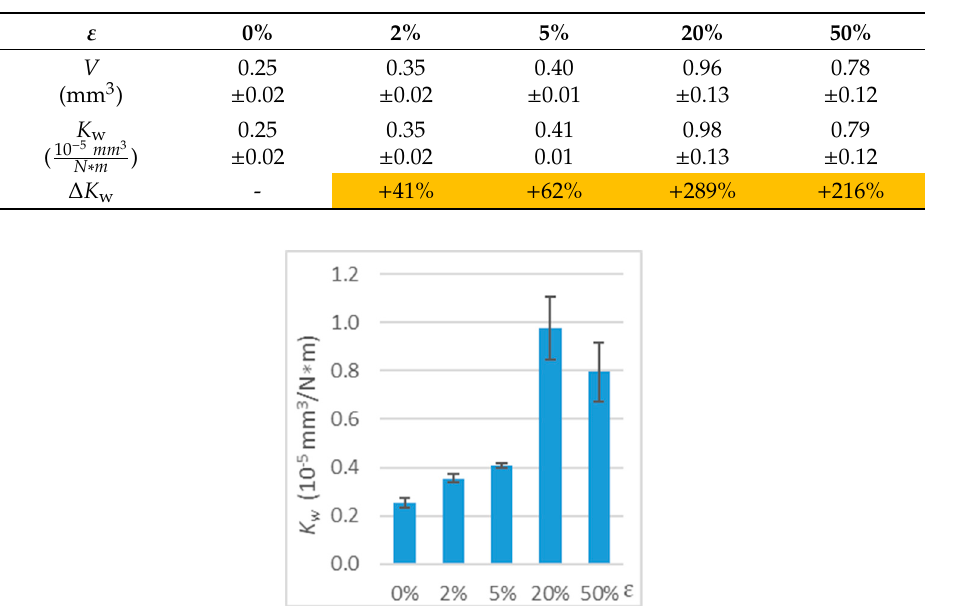
Figure 9. Wear coefficient ( K w ) for deformed polymer (working with steel, tension, parallel direction, v = 0.33 m/s, and T 0 = 23 °C). Table 2. Test results on the wear of deformed polymer (working with steel, tension, perpendicular direction, v = 0.33 m/s, and T 0 = 23 °C).